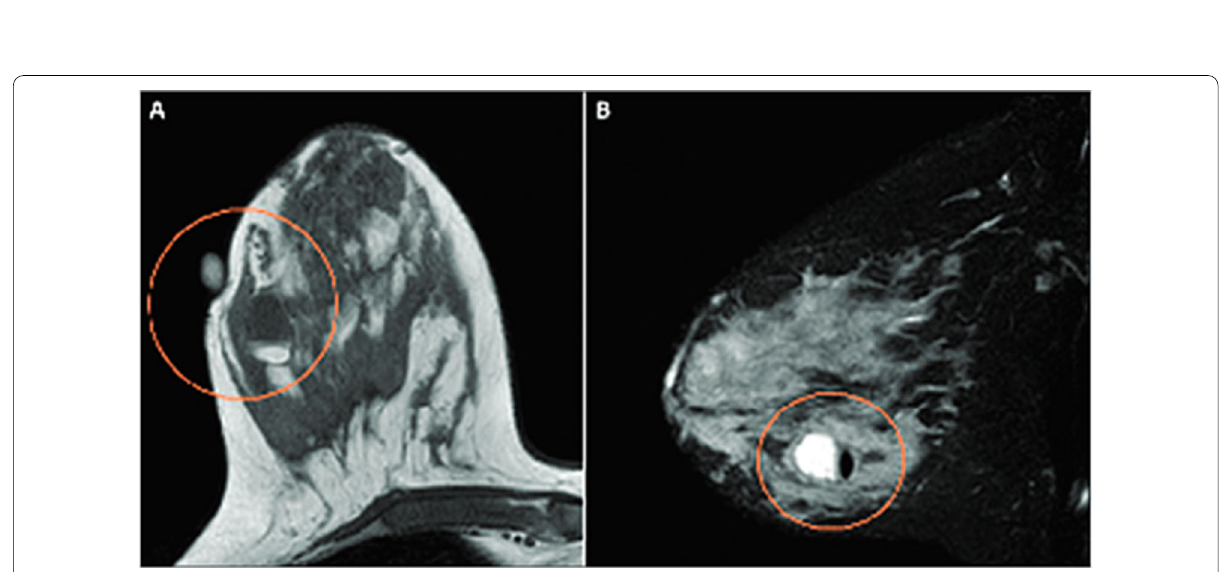
Fig. 4 Galactocele. Non Fat‑suppressed axial T1‑weighted (panel A ) and sagittal fat‑suppressed T2‑weighted (panel B ) images of lactating patient with galactocele are presented. Note : a cyst with thin septa, heterogeneous content, and fat‑fluid level is exhibited and compatible with galactocele diagnosis. Reproduced with permission from Radiologia Brasileira